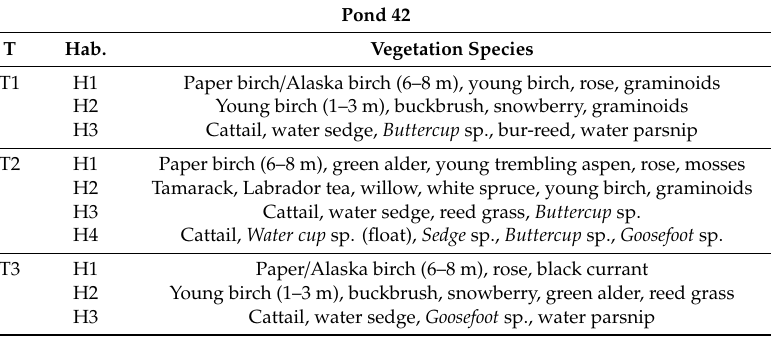
Table 7. Riparian vegetation species composition for Pond 42 (refer to Figure 11a for transect and derived habitat